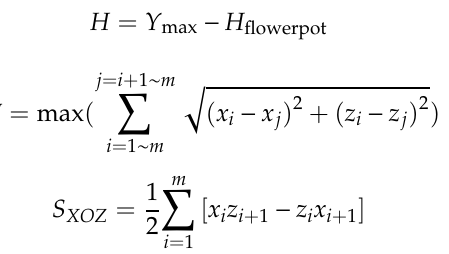
GTPs; ( b ) Metrics for assessing the accuracy of the GTP 3D point cloud